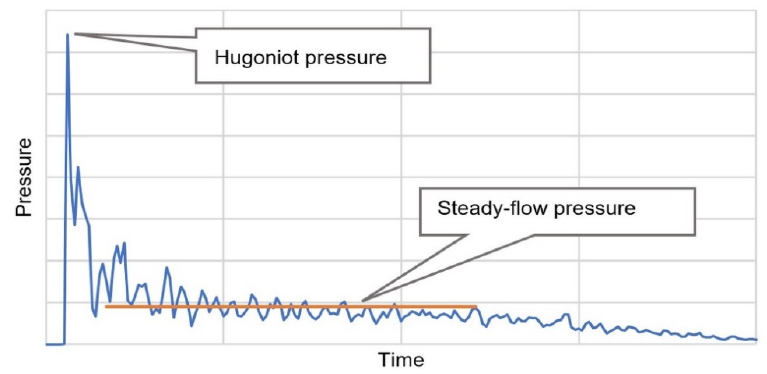
Figure 1. Phases of bird impact process. Adapted from Ref. [25].